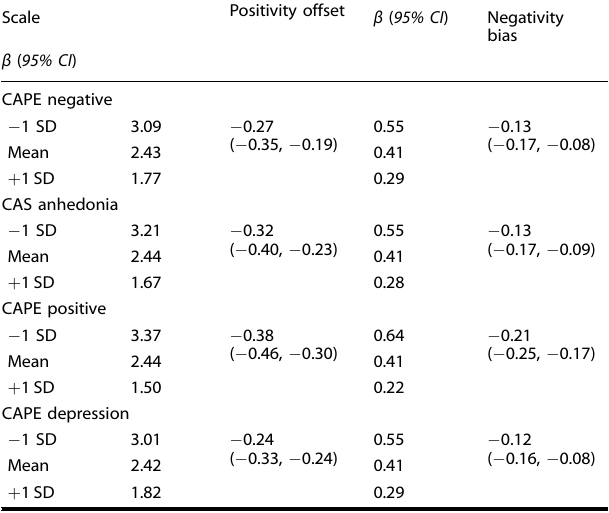
Table 2. Estimates of positivity offset and negativity bias for different levels of symptoms and overall effect of symptoms on positivity offset and negativity bias.